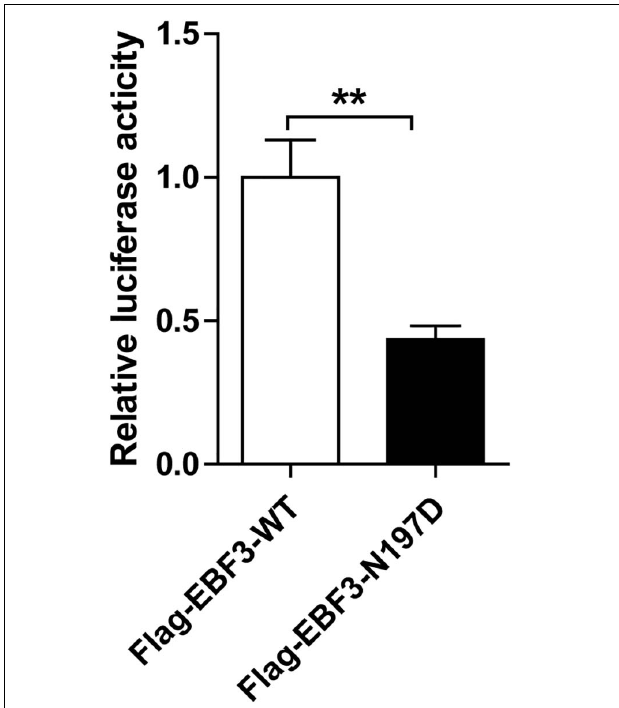
FIGURE 3 | Transcriptional activity of EBF3-N197D mutant in transfected cells. The transcriptional activity of p21 promoter in EBF3-N197D mutant was decreased. Results were mean ± SD for three individual experiments which, for each condition, were performed in triplicate. ** p < 0.01.